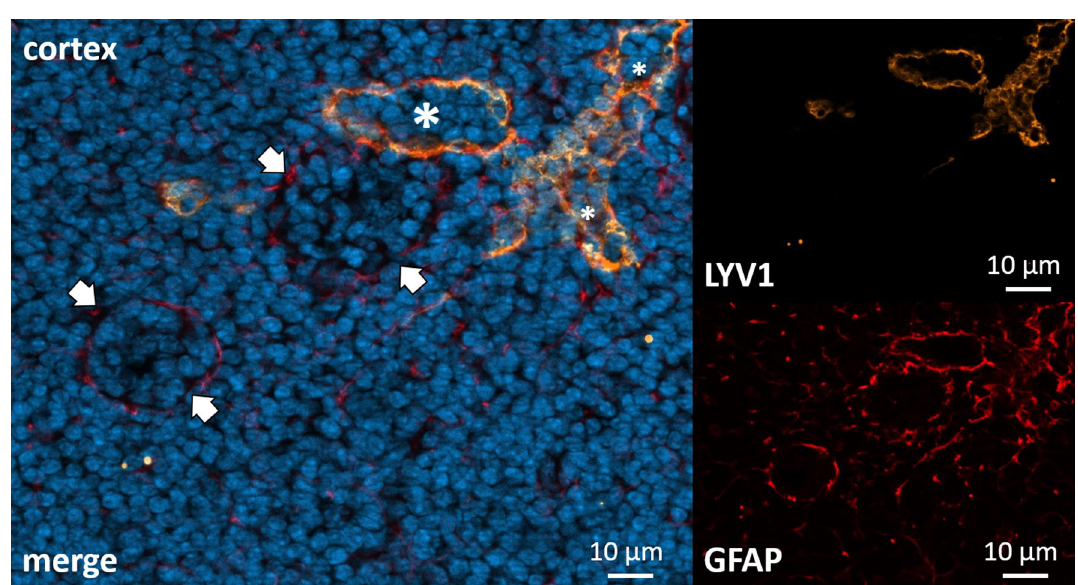
Figure 4. Cortex of a cervical lymph node. Immunohistochemical co-staining with polyclonal anti-GFAP antibody (DAKO) in red (directly conjugated) and anti-LYV1 in orange. DAPI for nuclear staining in blue. Lymphatic labyrinth (asterisk), here labeled by LYV1, shows colocalization with GFAP. GFAP also appears to be present in other vessel-like structures